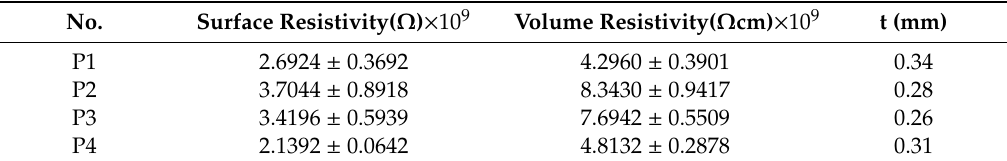
Table 4. Resistivity values of PTFE layers.